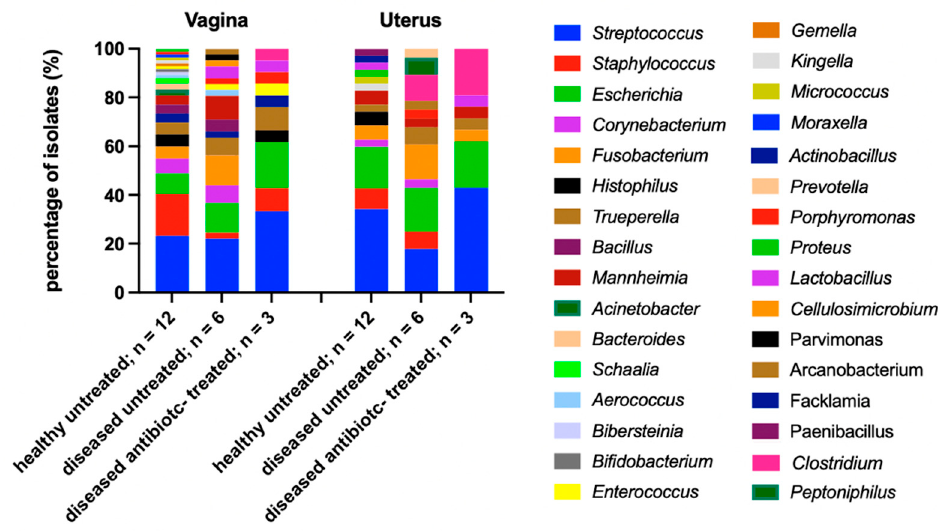
Figure 7. The vaginal and uterine microbiome of cows that remained healthy and received no treatment, compared to diseased cows with or without antibiotic treatment.